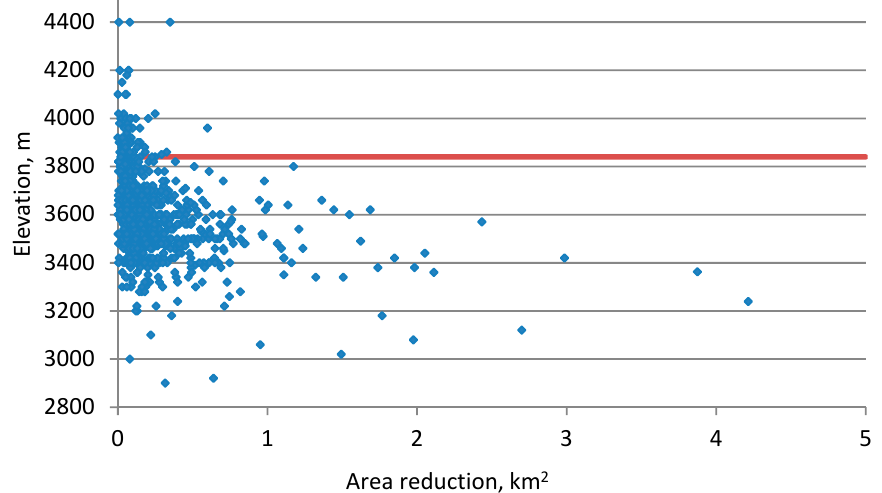
Figure 7. Absolute changes in glacier area versus the elevation of glacier termini between 1962 / 63 and 2012. Red line is mean regional ELA.